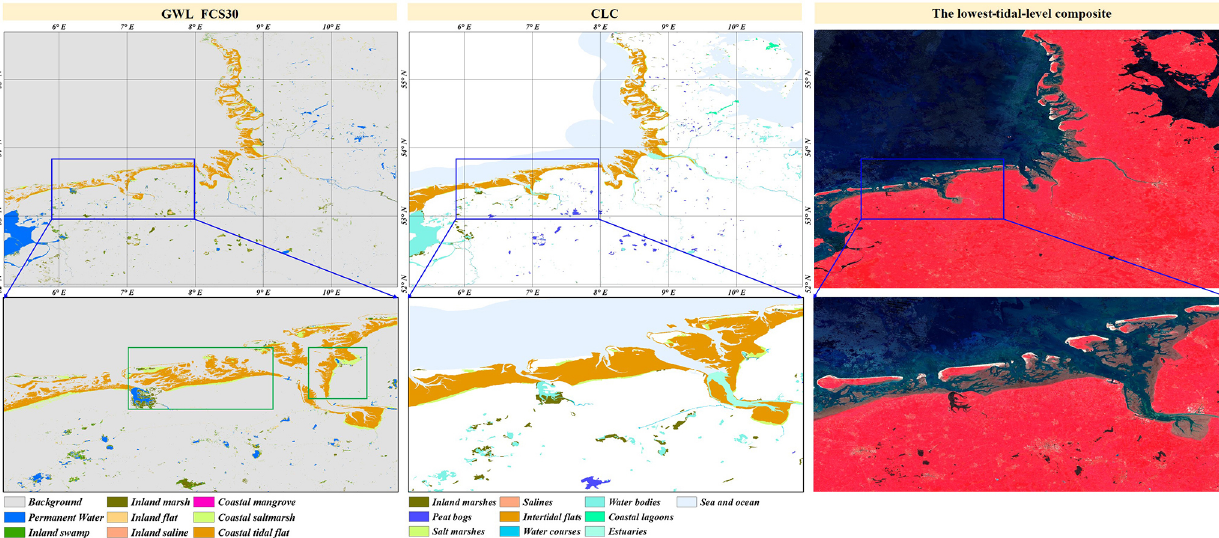
Figure 17. The comparisons between GWL_FCS30 and CORINE Land Cover (CLC) wetland layer in 2018 (https://land.copernicus.eu/ pan-european/corine-land-cover/clc2018?tab=metadata, last access: 22 November 2022). The lowest-tidal-level Landsat composite, com- posited by NIR, red and green bands, is